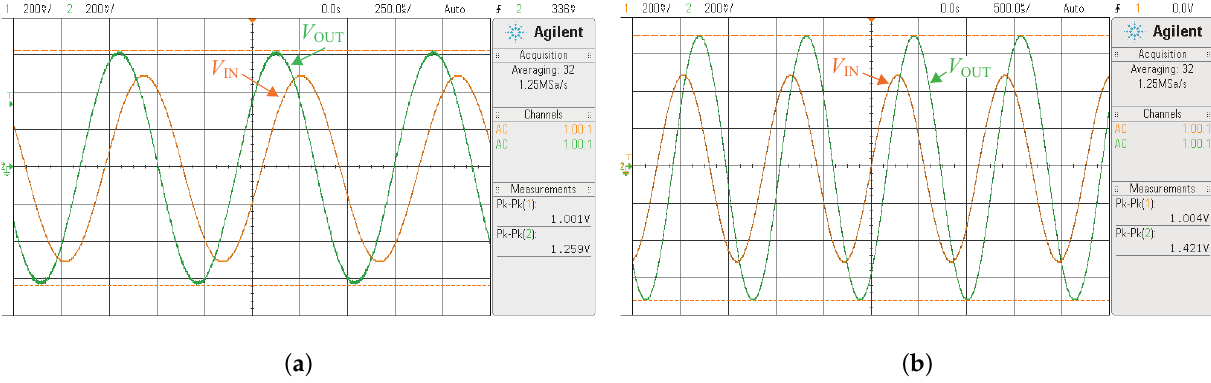
Figure 16. Input–output waveforms observed in oscilloscope for the proposed ( a ) ILPPLF ( α = 0.5 ) with an input frequency of f H = 1.212 kHz, ( b ) IHPPLF ( α = 0.5 ) with an input frequency of f H = 887.8